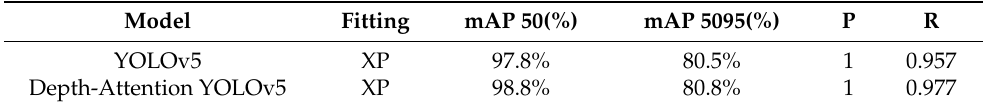
Table 6. Test results on the line test dataset of the YOLOv5 and the depth-attention YOLOv5.